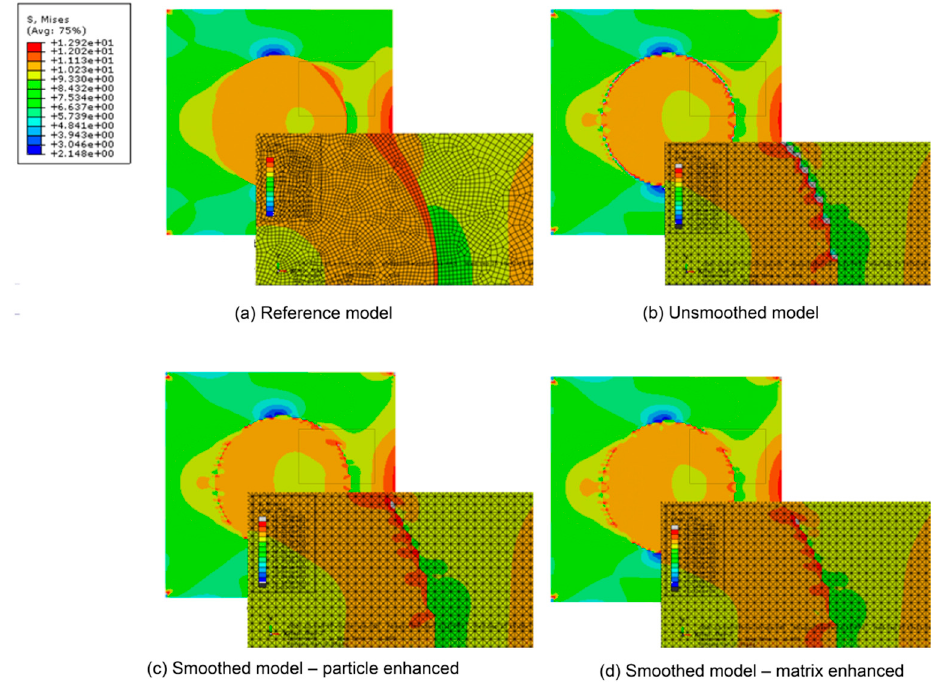
Figure 7. Von Mises stress distributions and details at interfaces: (a) reference model; (b) unsmoothed model; (c) smoothed model-particle enhanced; (d) smoothed model-matrix enhanced.